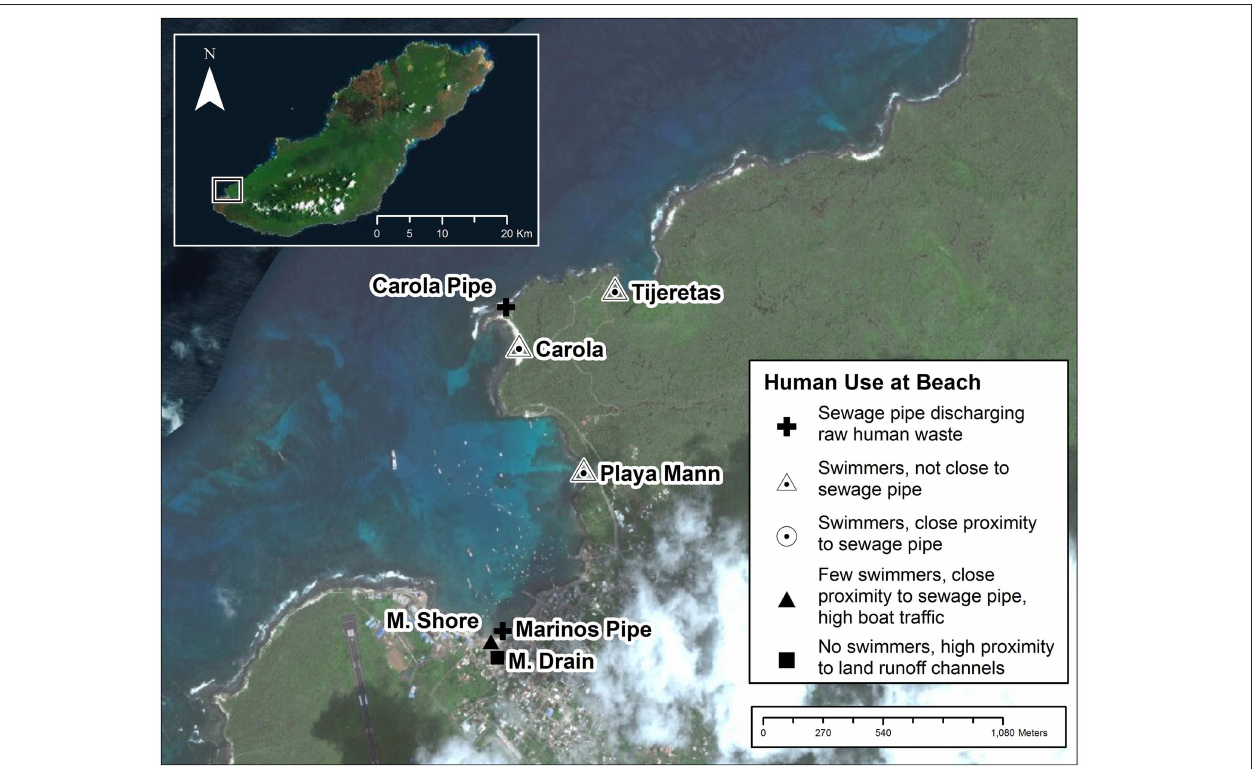
FIGURE 1 | Sample site locations and types of human use. Distances to sewage pipe are approximate and based on Euclidean measurements between points along the